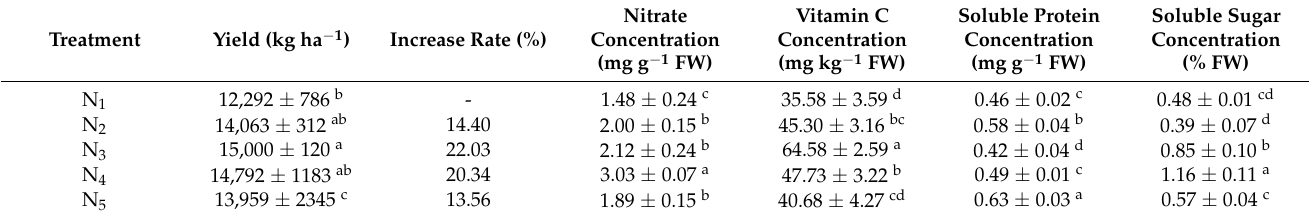
Table 2. Effect of different N application rates on yield and quality of lettuce.